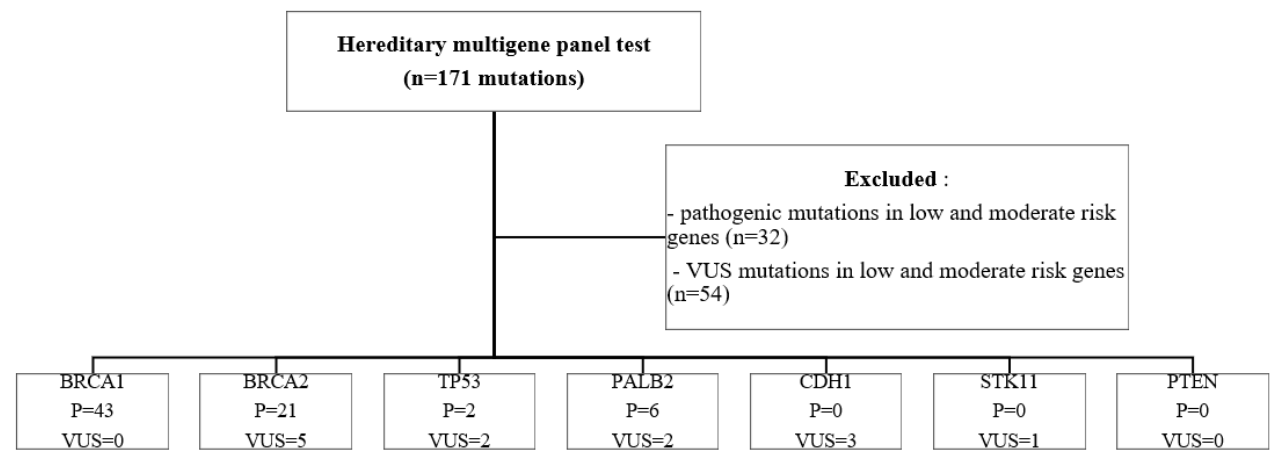
Figure 1. Study population—inclusion and exclusion criteria. P—pathogenic; VUS—variants of unknown significance .